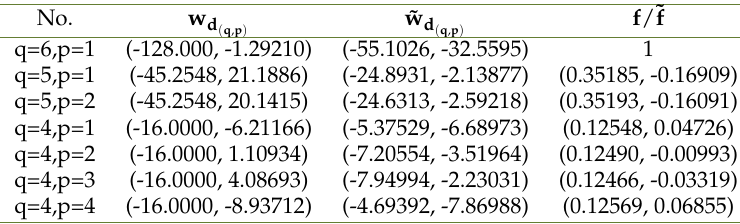
Table 1. TIFV using Haar.